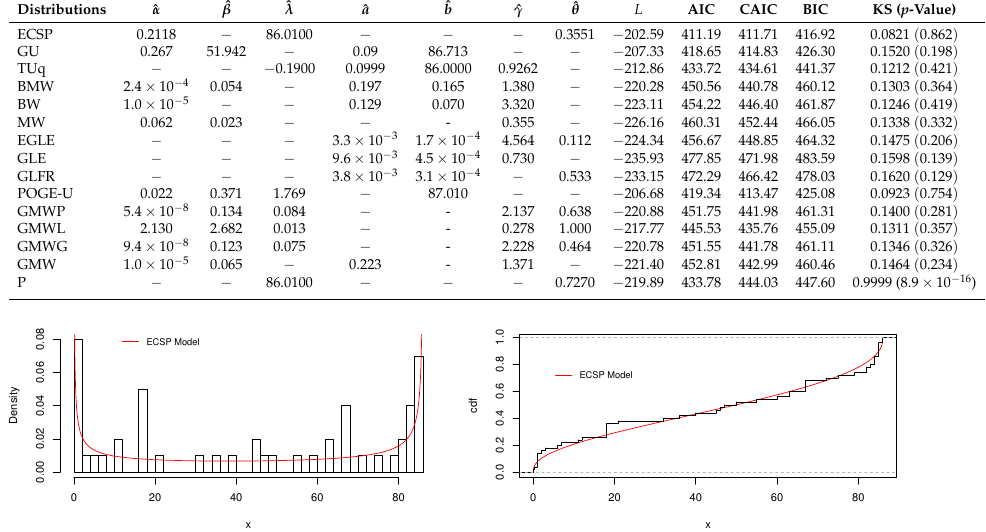
Figure 12. Plots of the histogram with the estimated pdf, and empirical cdf with estimated cdf of the ECSP model for real data I.